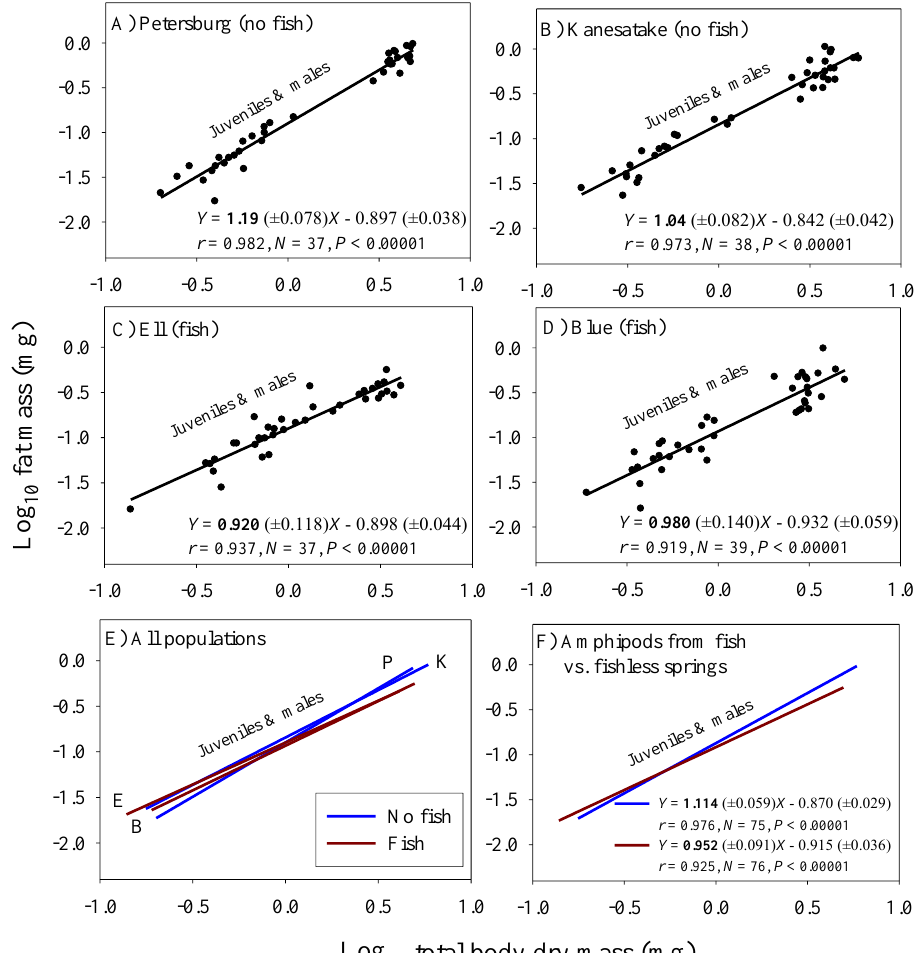
Figure 3. Log 10 fat mass in relation to log 10 dry body mass for juveniles and adult males in four populations of the amphipod Gammarus minus . Least squares regression lines and equations are shown (numbers in parentheses are 95% confidence intervals for the intercepts and slopes; r = correlation coe ffi cient; N = sample size; P = probability that the correlation is due to chance). Scaling relationships for two populations in springs without fish predators ( Cottus cognatus ) ( A , B ), for two populations with fish predators ( C , D ), for all four populations compared ( E ), and for the populations with versus without fish, each analyzed collectively ( F 316 The fat-mass scaling exponents ( b FAT ) can be used to adjust the scaling exponents for assimilation 317 rate observed in the laboratory under ad libitum food conditions ( b L ) to infer the scaling exponents for 318 assimilation rate in the field ( b F ), by using equation 4. As a result, b F is inferred to be lower for the 319 populations inhabiting springs with fish (0.671 - 0.048 = 0.623) than for the populations inhabiting 320 springs without fish (0.682 + 0.114 = 0.796). 321 322